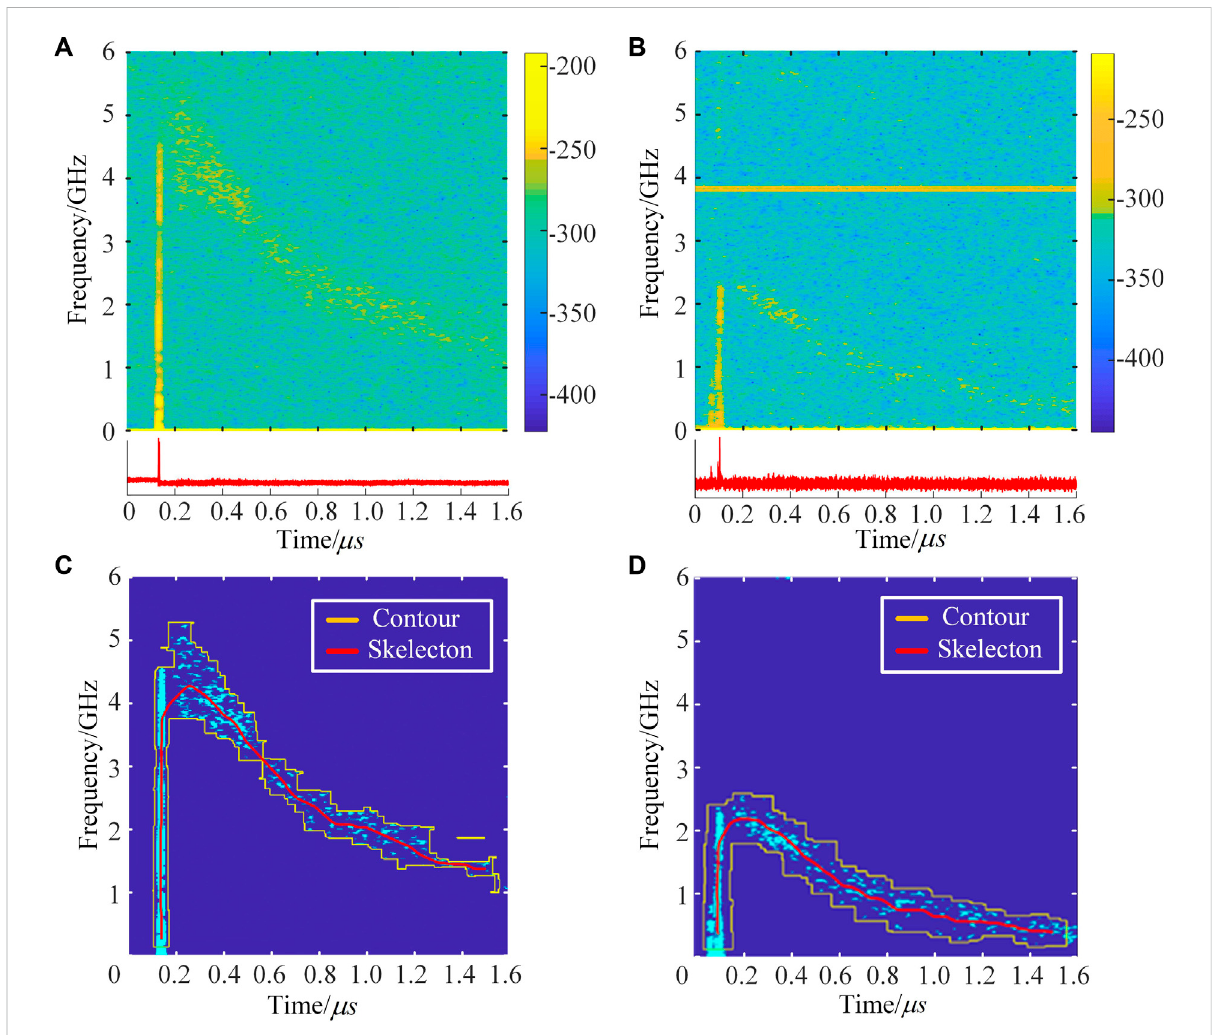
FIGURE 3 Comparisonofthetime-frequencyridgeextractiondiagrammeasuredbydifferentsystems. (A) Time-frequencyenergymapmeasuredbyPDV, (B) Time-frequency energymap measuredbyQT-PDV.After image processing by thresholding, skeletonextraction, fi ltering,and connectivity,After image processing by thresholding, skeleton extraction, fi ltering, and connectivity, the yellow line indicates the extraction outline and the red